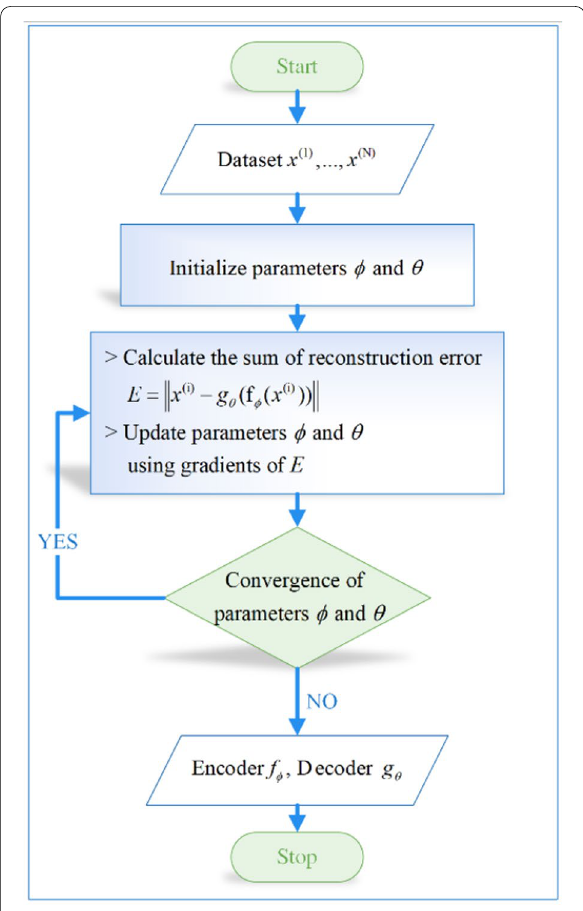
Fig. 2 The flow chart of the autoencoder training algorithms